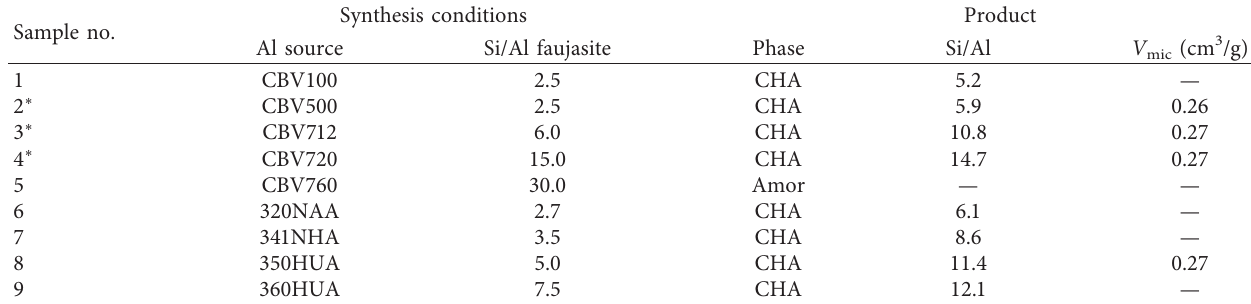
Table 1: Synthesis parameters of high-silica CHA zeolites using faujasites as Al sources and some product properties. Sample no.